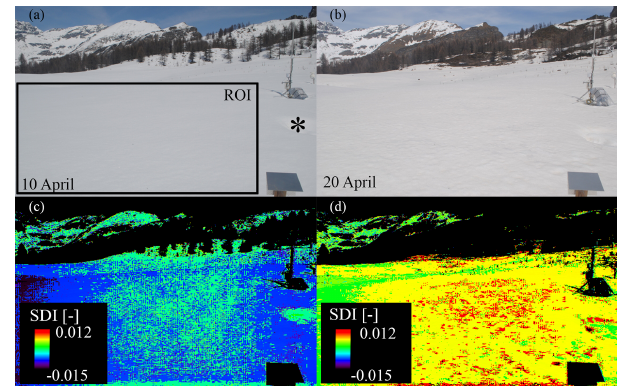
Figure 7. (a, b) Examples of digital images acquired from the Phe- nocam installed at Torgnon before and after the resurfacing of dust layers. (c, d) Snow darkening index (SDI) calculated using the red and green channels of the images. A region of interest (ROI, a ) was used to create SDI time series. The asterisk in (a) indicates the po- sition of the snow